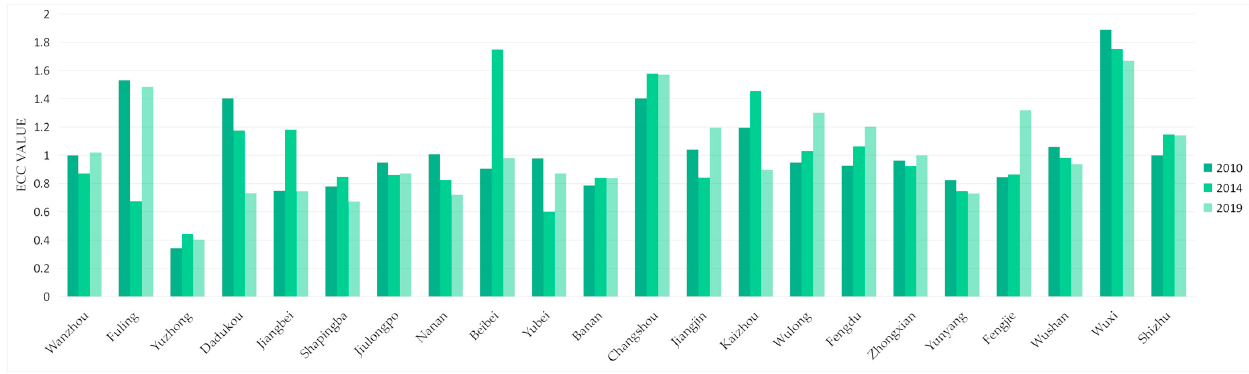
Figure 8. Changes of ECC in Three Gorges Reservoir Area (Chongqing section). Sources: Calculation results of ECC in Three Gorges Reservoir Area (Chongqing section).